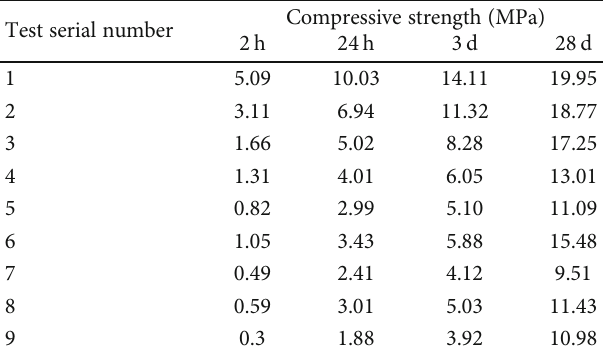
Table 5: Mechanical property test results. Test serial